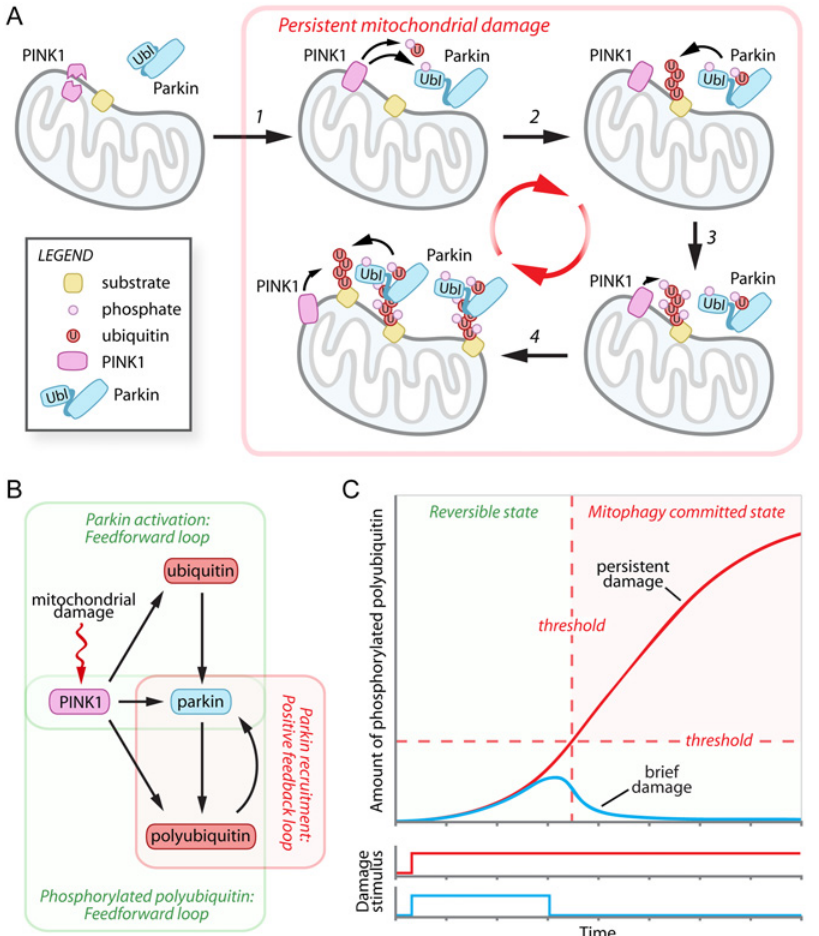
Figure 1. Damage-induced feedforward and positive feedback loops mediate the cellular decision to destroy mitochondria. (A) In healthy cells the mitochondrial kinase PINK1 is proteolytically processed and degraded by the UPS. Following mitochondrial damage, PINK1 is stabilized and phosphorylates ubiquitin and the Parkin UbL ( step 1 ), activating Parkin and promoting the polyubiquitination of mitochondrial outer membrane substrates ( step 2 ). The polyubiquitin chains are then phosphorylated by PINK1 ( step 3 ) and mediate the recruitment of additional Parkin to the mitochondria ( step 4 ). (B) Network motifs in the PINK1- Parkin pathway. Mitochondrial damage inhibits PINK1 degradation, initiating dual coherent feedforward loops in the activation of Parkin and generation of phosphorylated polyubiquitin and a positive feedback loop in Parkin recruitment. (C) Hypothetical graph modeling the relationship between mitochondrial damage signal persistence (brief — blue line , and persistent — red line ) and the accumulation of phosphorylated polyubiquitin chains during the progression towards mitophagy commitment. UPS, ubiquitin-proteasome